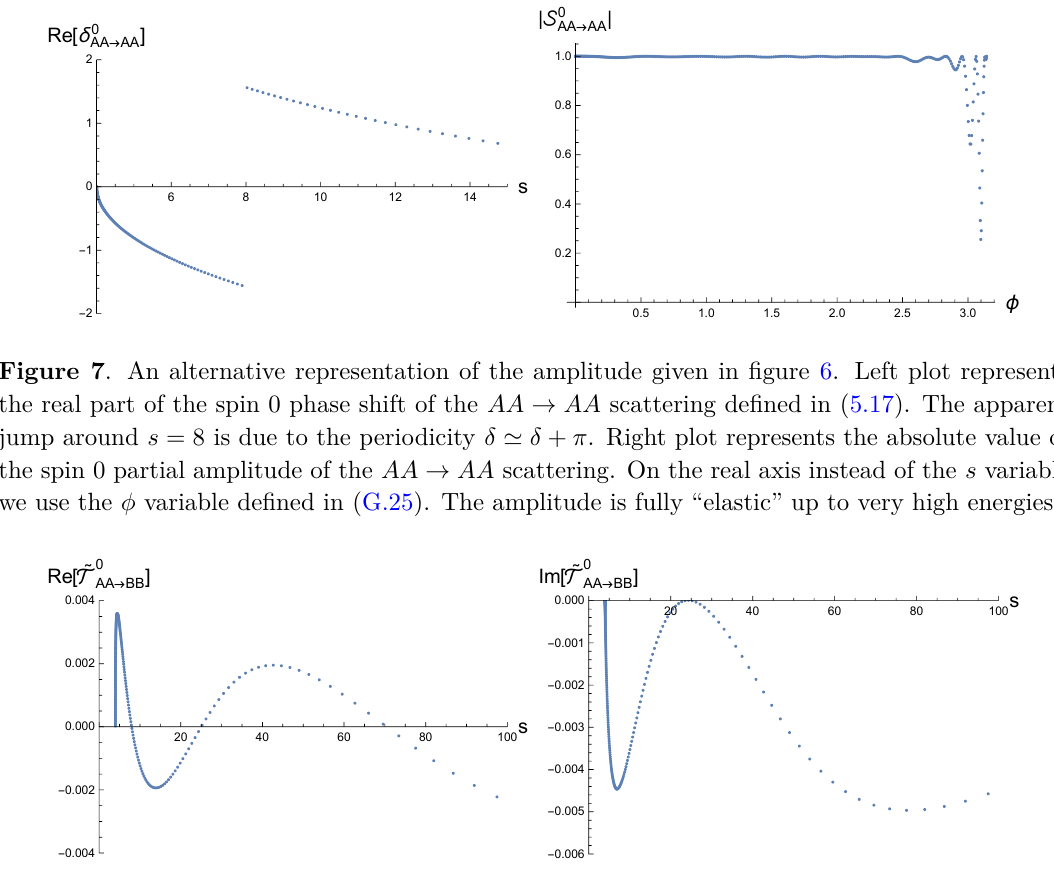
Figure 8 . Real and imaginary parts of the spin 0 interacting part of the AA → BB partial amplitude leading to the absolute minimum of the a -anomaly. It is constructed at N max = 20 and L max = 30